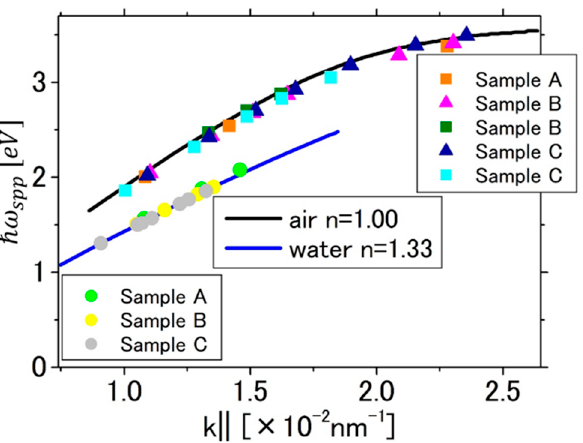
Figure 7. Experimental data compared with calculated dispersion relations (Equation (3)) of SPP for Ag ( 𝜀 (cid:2870) from [23] in contact with air and water (𝜀 (cid:2869) = 1 and 1.33 (cid:2870) ) .